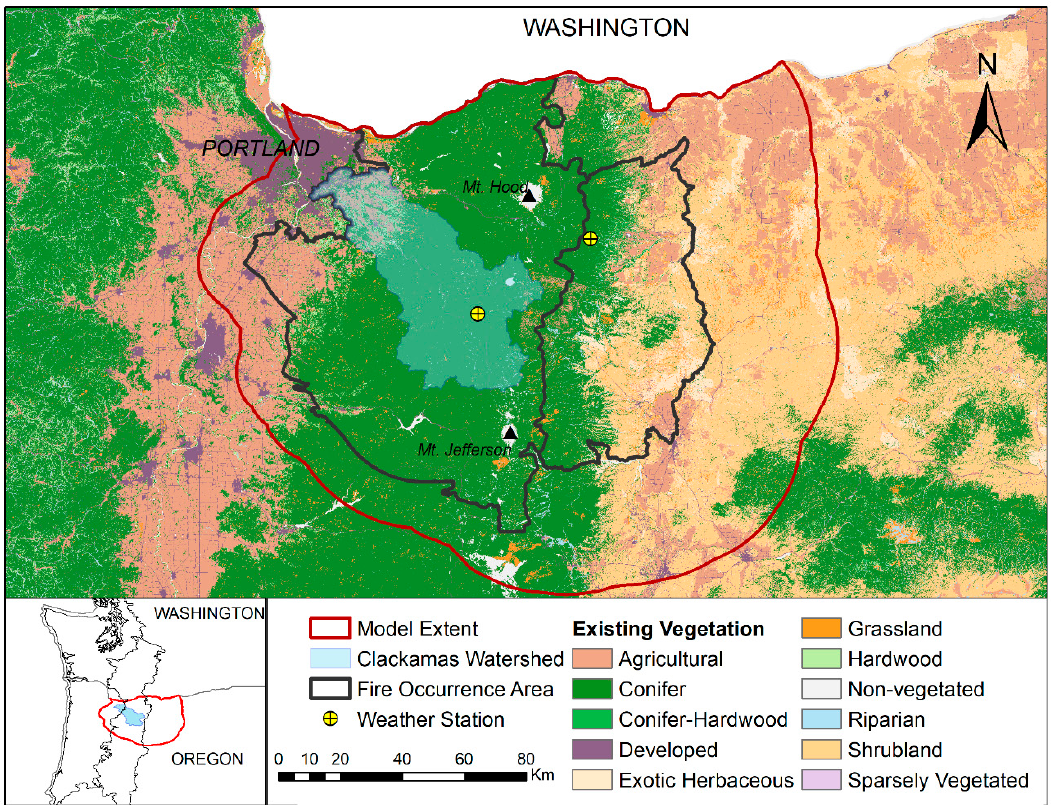
Figure 2. Extent of FSim modeling. The model extent was divided into two fire occurrence areas (FOAs) in order to distinguish between very different fire environments on either side of the Cascade Range crest. Each FOA was associated with a unique weather station from which empirical observations were used in the baseline scenarios, and modified to reflect projected future climate conditions. The FOA defines the area within which FSim simulated ignitions and is significantly larger than the analysis area, the Clackamas Basin, in order to allow for fires that ignite outside the analysis area but eventually burn into it.